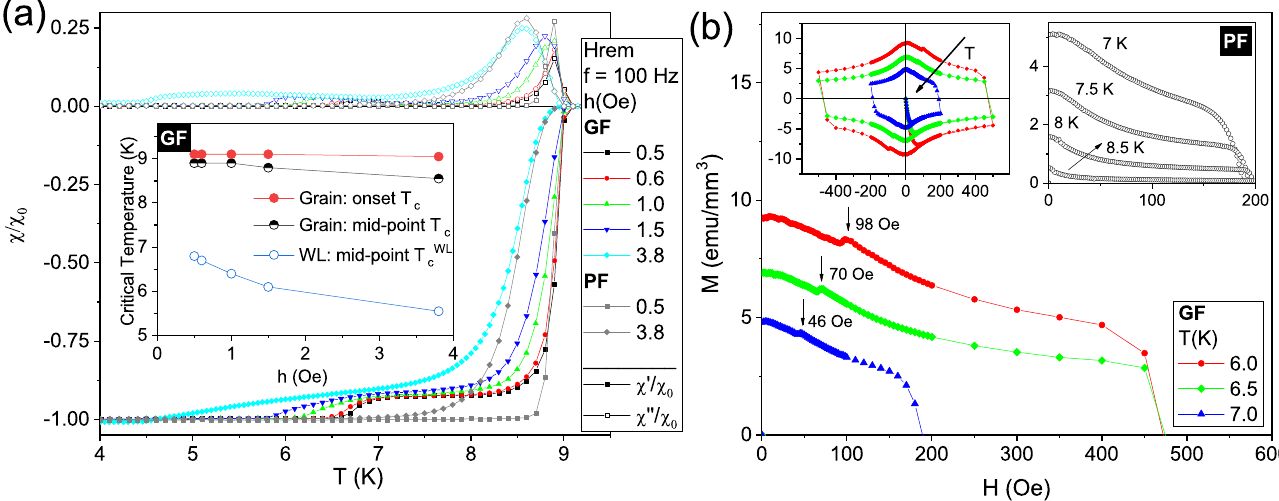
Figure 2. (Color online) ( a ) Temperature-dependent AC susceptibility for two different samples: a plain film (PF) and a structured film with a central groove (GF). The measurements were taken for 100 Hz and remnant DC field ( H rem ). Open symbols (above the line at χ / χ 0 = 0) represent the χ (cid:48)(cid:48) component, while closed symbols (below χ / χ 0 = 0) are χ (cid:48) values. The inset presents the critical temperatures versus AC field amplitude ( h ) obtained for the GF specimen using different criteria. ( b ) Detail of magnetic moment versus DC applied field ( H ) curves taken at different temperatures ( T ) for the GF sample. The upper left inset presents the complete hysteresis loops for the GF sample, whereas the upper right inset shows the forth quadrant of the M ( H ) curves for the PF sample at different temperatures. The axis units are consistent throughout the